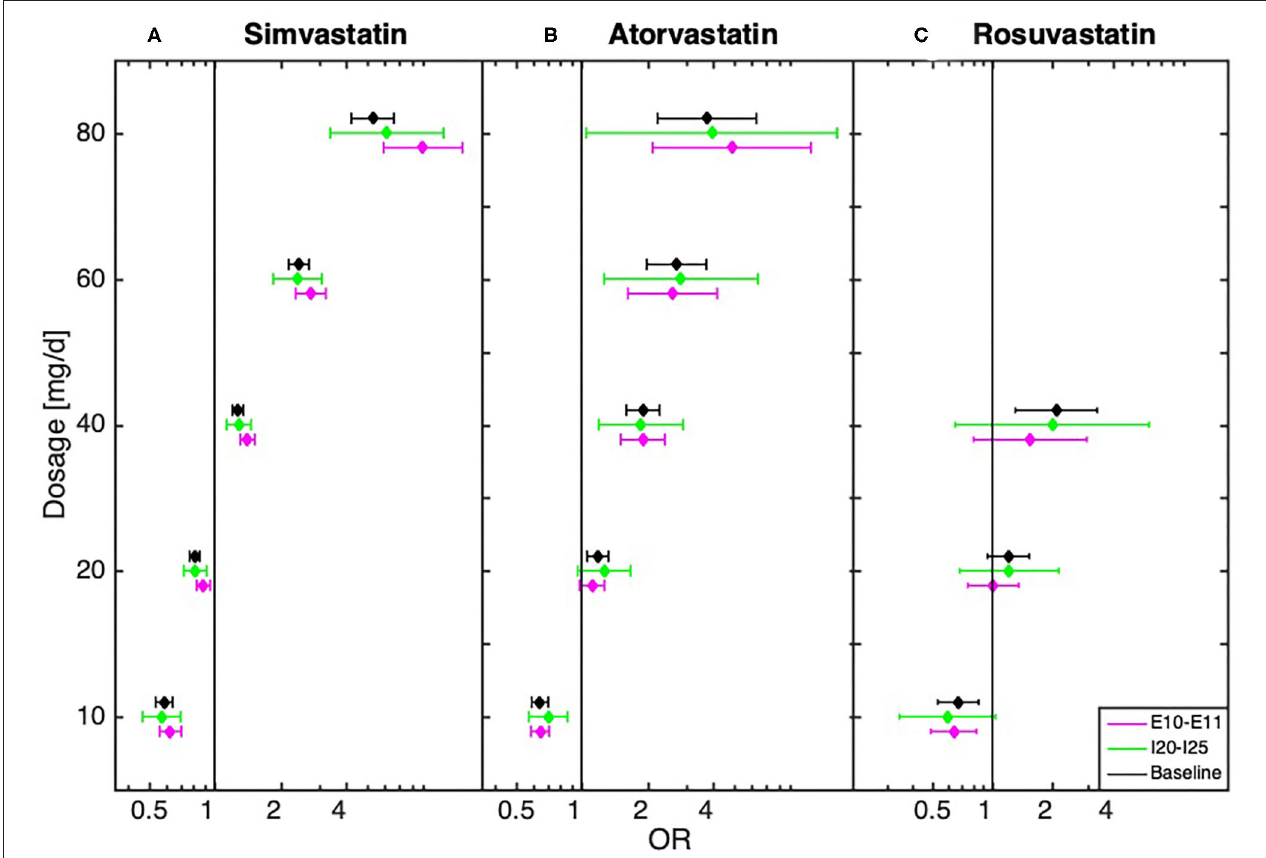
FIGURE 2 | Dose-dependent relationship between (A) simvastatin, (B) atorvastatin, and (C) rosuvastatin and diagnosis of depression for baseline (all statin-treated patients) and after the exclusion of patients with cardiovascular disease (I20–I25, n = 53,414) and ( n = 71,722)/or diabetes (E10–E11, n = 32,815) obtained from the logistic regression